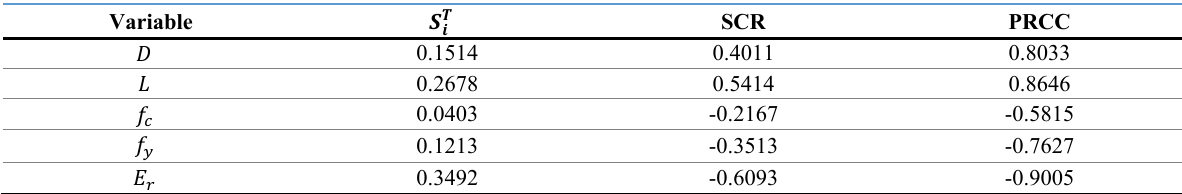
Table 5. Sensitivity analysis for the beams of the structural